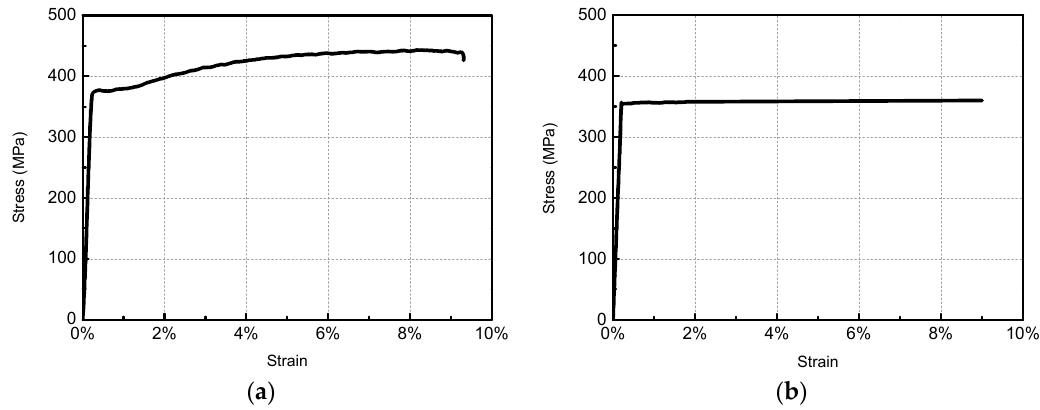
Figure 3. Measuring devices.